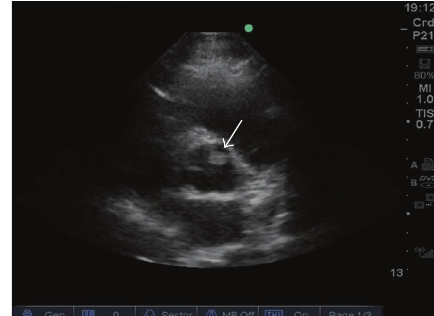
Figure 1: Ultrasound parasternal short axis view showing the aortic valve with the circular well circumscribed hyperechoic area, consis- tent with a vegetation or valvular mass.